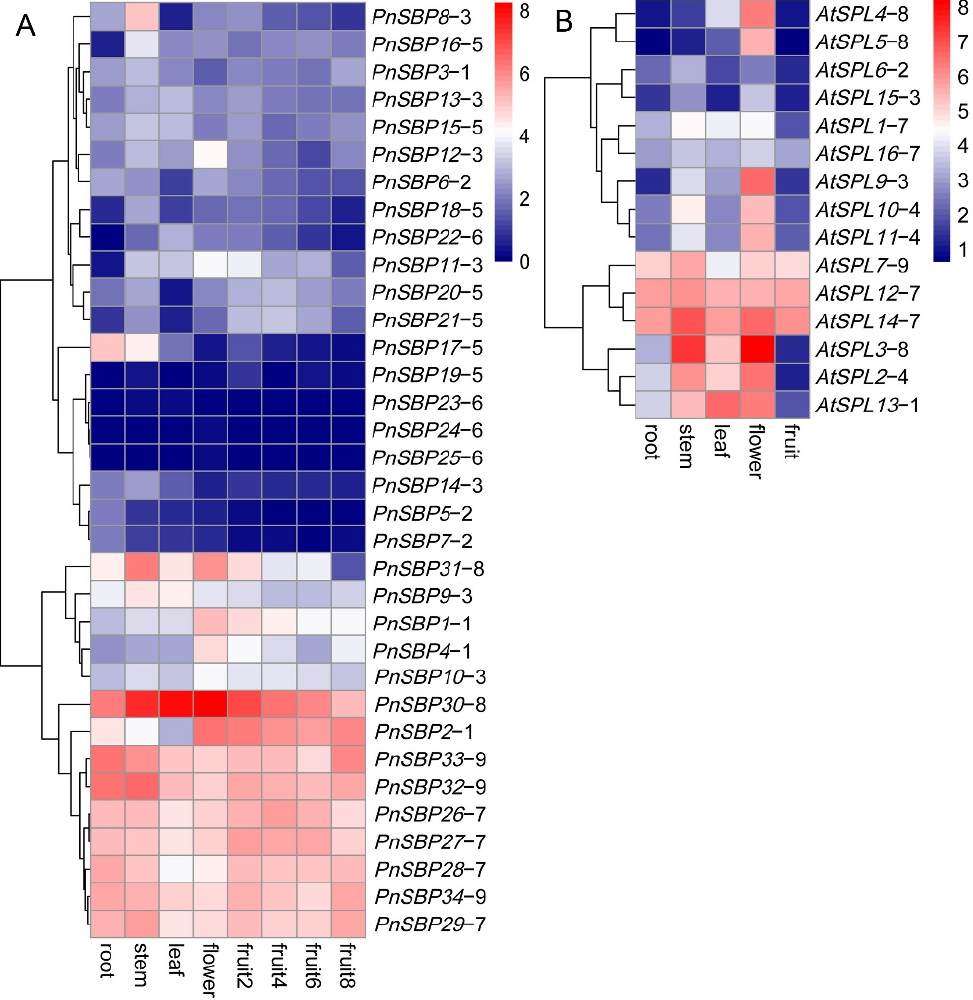
Figure 7. The heatmap of tissue expression of pepper SBP genes. The FPKM values have been log2 transformed. The group number of each gene was marked after the gene name. ( A ) The expression patterns of pepper SBP genes. ( B ) The expression patterns of A. thaliana genes.